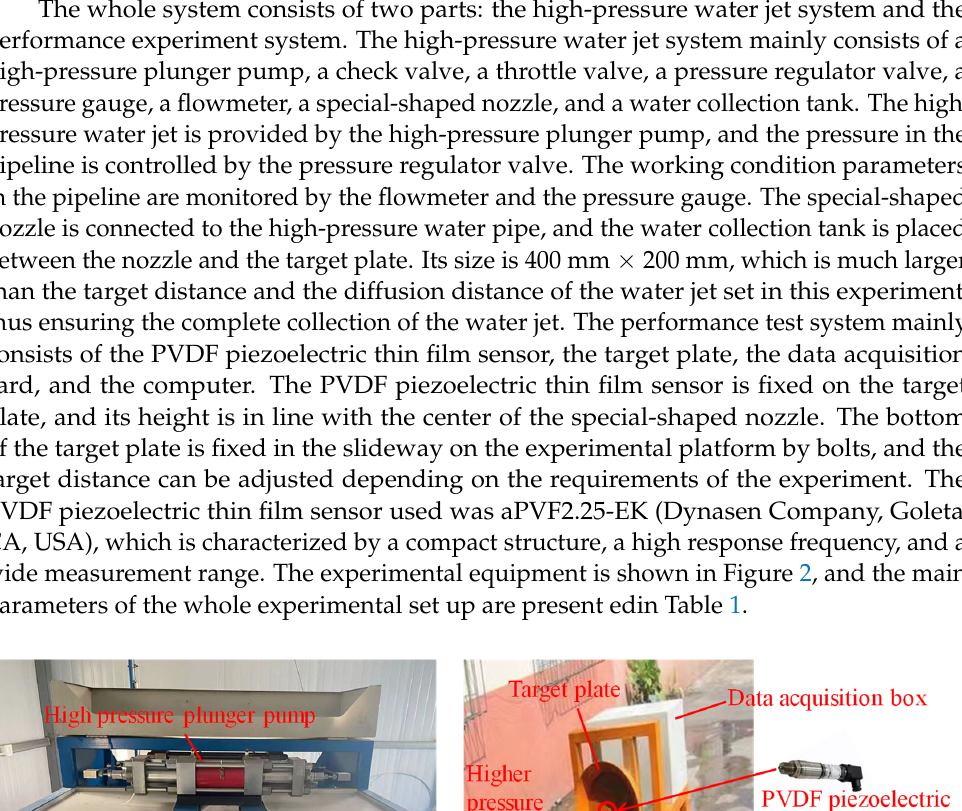
Figure 1. Schematic of the water jet performance test system.